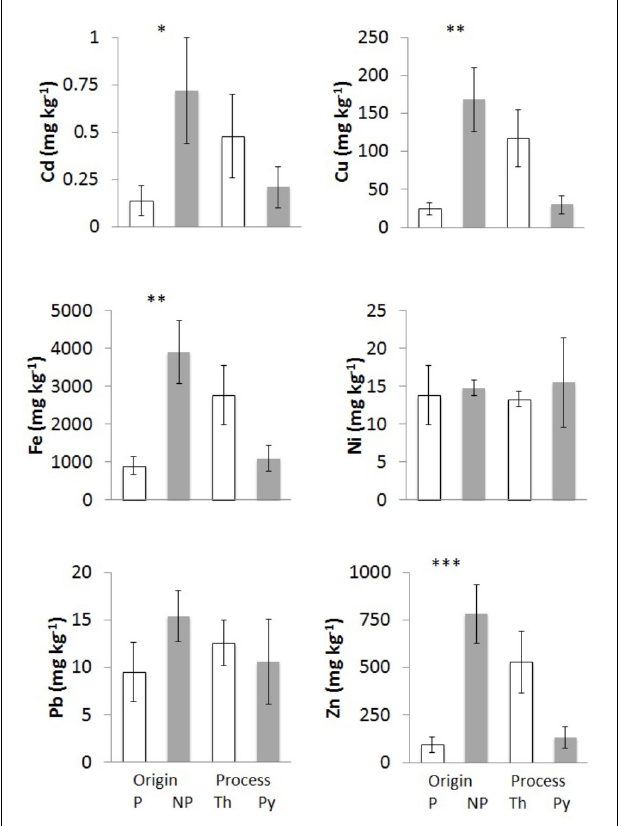
FIGURE 2 | Trace element concentrations of chars from different feedstocks and production processes: Cd, Cu, Fe, Ni, Pb, and Zn. Bars “P” indicate chars of plant origin (A3, A4, E – white) and bars “NP” chars of non-plant origin (A1, A2 – gray). Bars “Th” indicate chars from (thermo)reforming (A1, A2, A3 – white), and “Py” chars from pyrolysis (A4, E1 – gray). Means of at least three biological replicates per char are reported, with standard error of the mean. Asterisks show the significance of pairwise comparisons (one-way ANOVA) between chars derived from different feedstocks (P/NP) or from different processes (Th/Py): ∗ p < 0.05; ∗∗ p < 0.01; ∗∗∗ p <